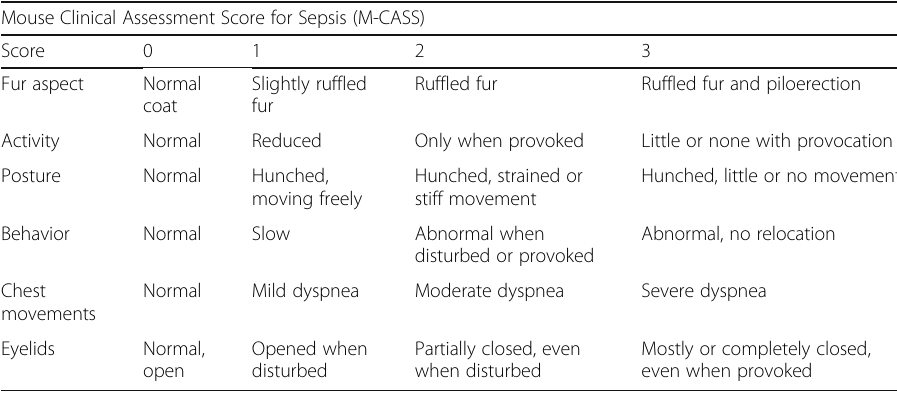
Table 2 Modified M-CASS scoring system for monitoring of surrogate endpoints and assessment of disease severity in mouse CLP sepsis, adapted from Huet et al. [5] Mouse Clinical Assessment Score for Sepsis (M-CASS)